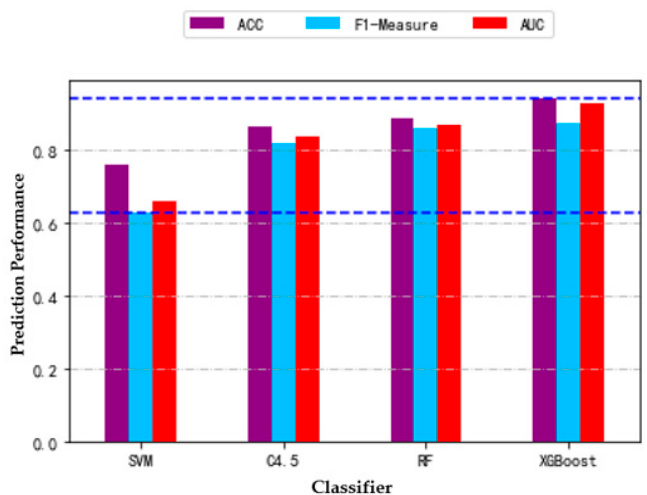
Figure 2. Prediction performance (accuracy, F1 measure, and AUC ) of each classifier using their optimal features subset. (The blue dotted line represents the position of the maximum or minimum value).